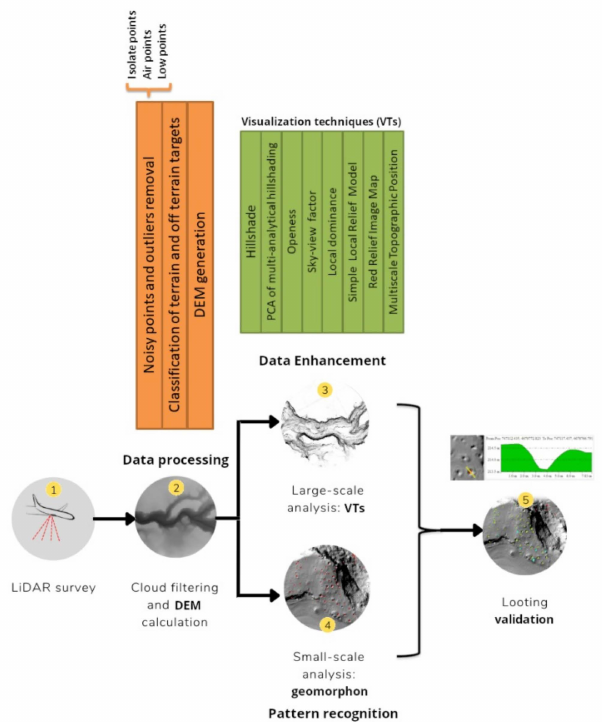
Figure 2. Flow chart summarizing the methodology followed to extract looting in S. Giovenale study